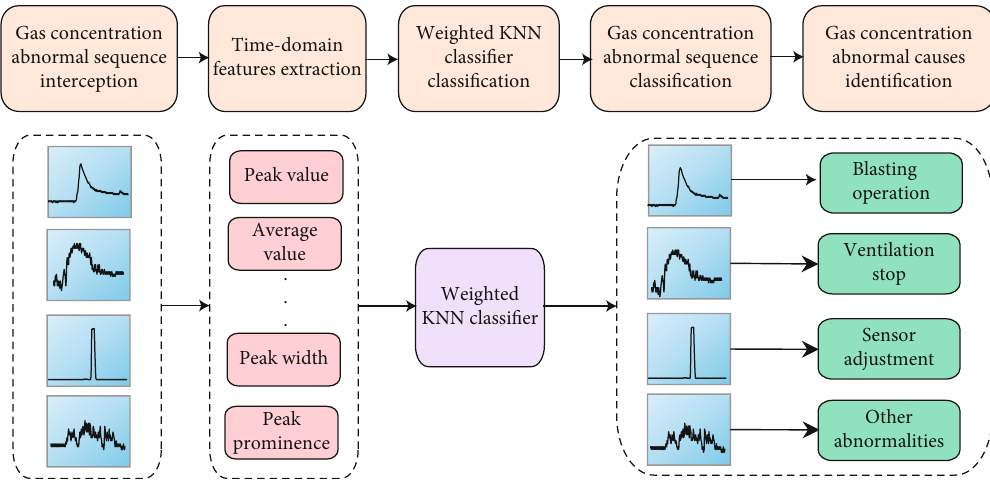
Figure 3: Identi fi cation method of abnormal gas